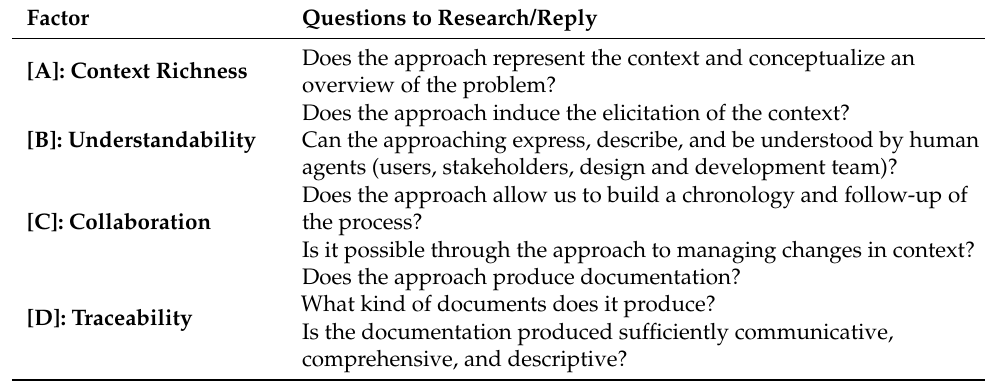
Table 3. Measurement factors to be